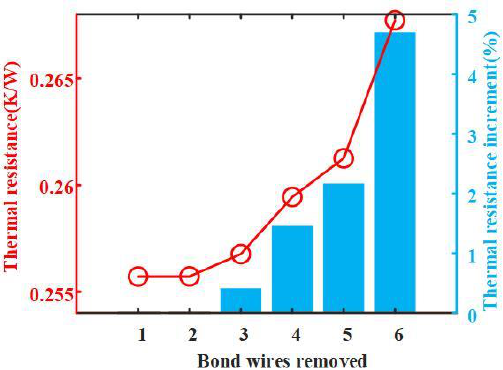
Figure 19. Measured thermal resistance using die power dissipation.